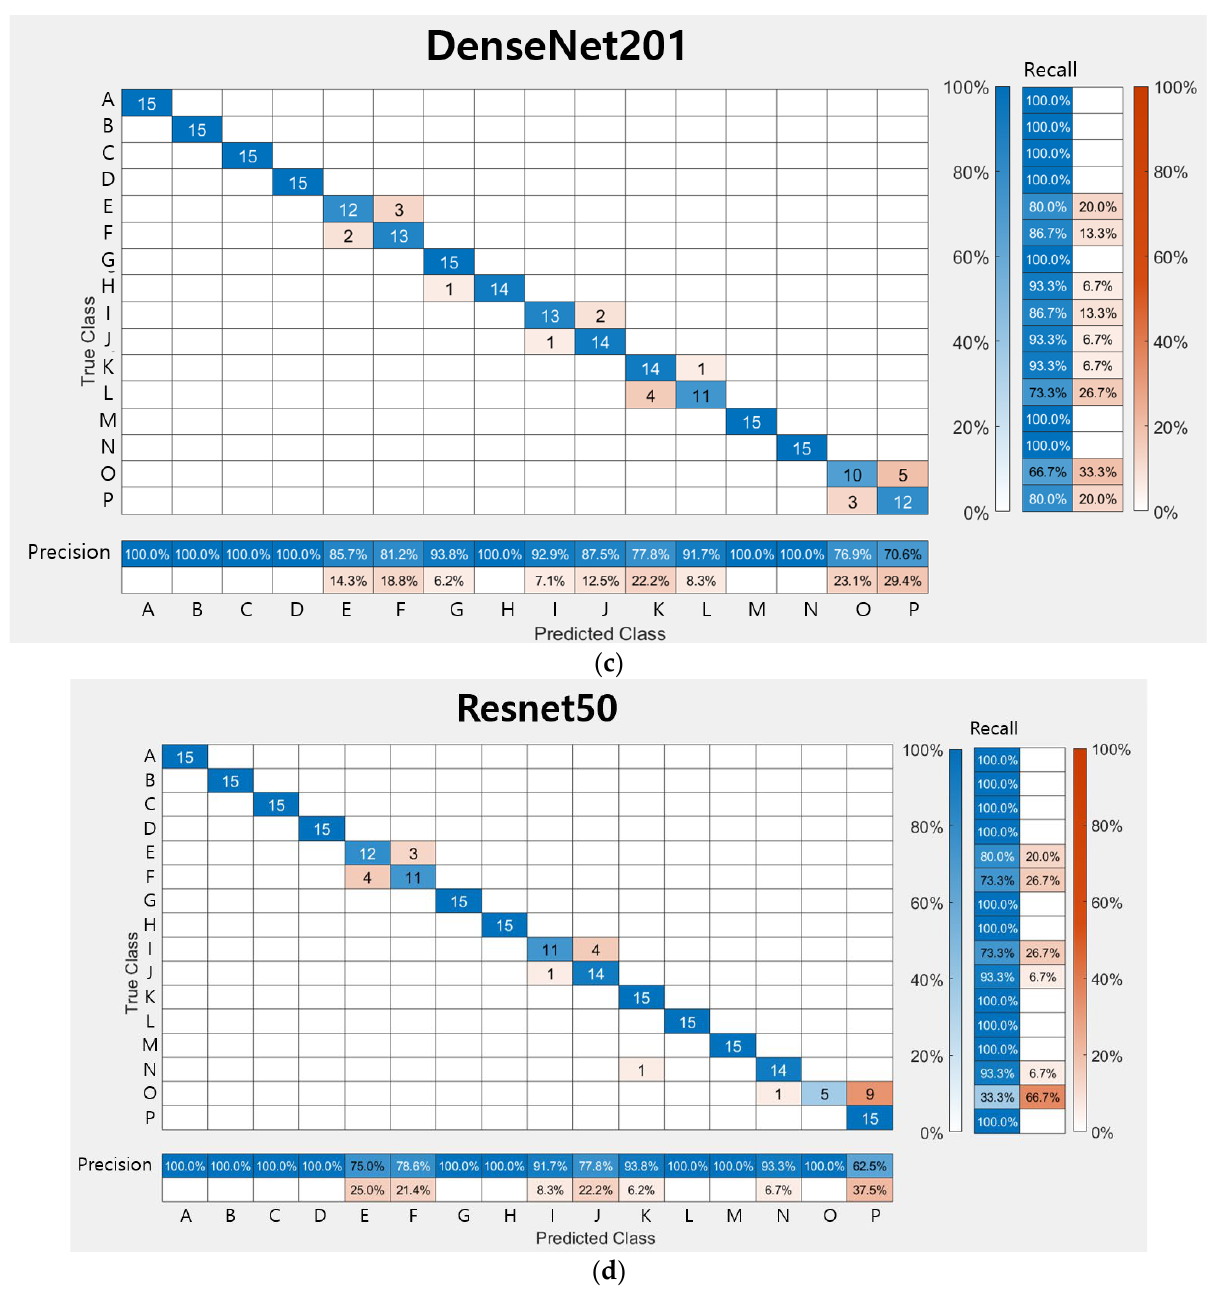
Figure 21. Confusion charts: ( a ) Initially designed simple network; ( b ) Modified simple network; ( c ) DensNet 201 and ( d ) ResNet50.